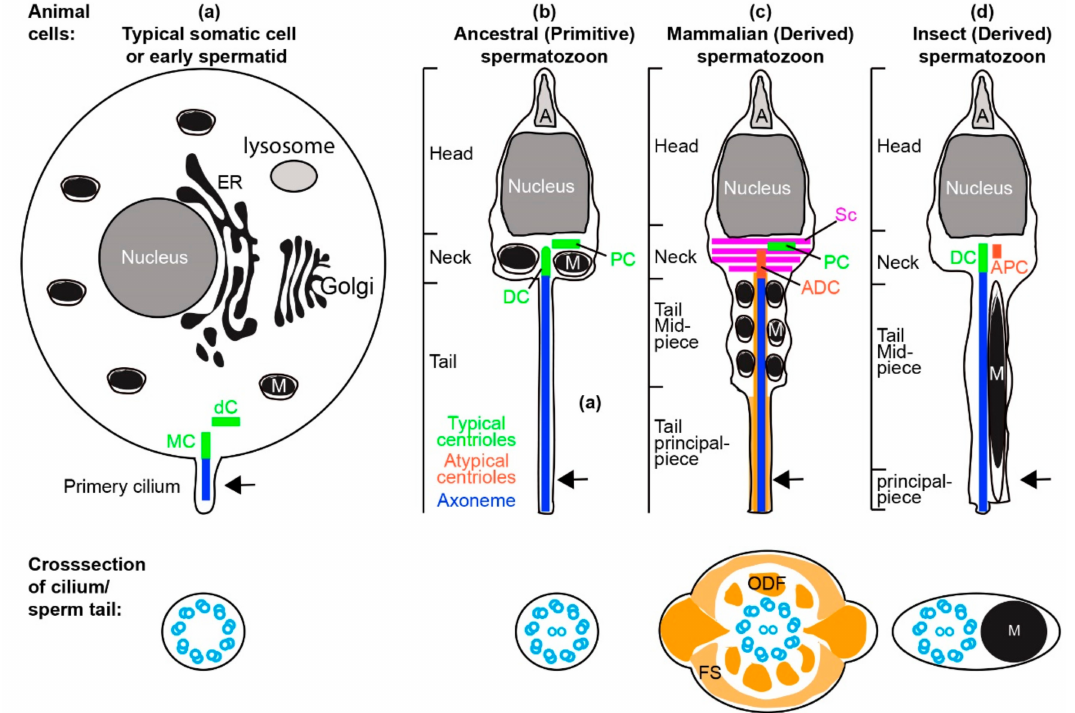
Figure 1. Centrioles in somatic cell and spermatozoa. ( a ) A representative undifferentiated somatic cell (e.g., stem cell in G1 phase of the cell cycle) or early spermatid with all organelles, and two typical centrioles: the mother centriole (MC) and daughter centriole (dC), and a short non-motile primary cilium. The primary cilium contains an axoneme made of nine doublets of microtubules. ( b ) Model of the ancestral “primitive” spermatozoa made of head, neck, and tail. The neck contains mitochondria (M) and two typical centrioles: the distal centriole (DC) and proximal centriole (PC). The Golgi forms the acrosome (A), the nucleus reshapes, and the endoplasmic reticulum (ER) is dramatically modified to a remnant. The sperm tail contains an axoneme made of nine doublets of microtubules with two central singlet microtubules. ( c ) Model of the mammalian spermatozoa made of head, neck, and tail that are divided into a midpiece and principle piece. The neck contains one typical proximal centriole and one atypical distal centriole. Additionally, the neck contains accessory structures that exhibit bilateral symmetry (e.g., striated column, SC). The mitochondria are found with the cytoplasmic axoneme in the midpiece [13]. The sperm tail contains the axoneme made of nine doublets of microtubules with two central singlet microtubules and accessory structures (outer dense fiber, ODF, and fibrous sheath, FS) that exhibit bilateral symmetry. ( d ) Model of the insect spermatozoa made of head, neck, and tail that is mostly a midpiece and with a tiny principle piece. The neck contains one typical distal centriole and one atypical proximal centriole. The sperm tail contains the axoneme made of nine doublets of microtubules with two central singlet microtubules. Asymmetrically located mitochondria are found along one side of the cytoplasmic axoneme along most of the sperm tail; this section is homologues to the midpiece in mammalian sperm [14]. Arrow in the animal cells indicated the plane of the cross-section in the cilium/sperm